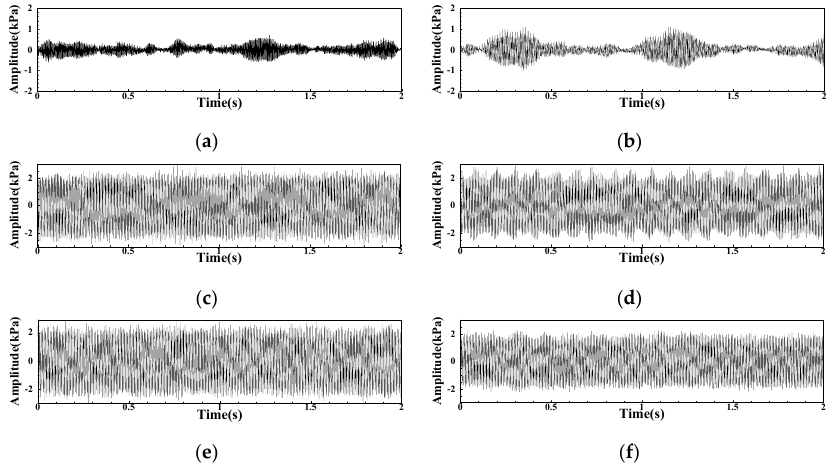
Taking the LA group as an example for the DP signal of the L combustor, Figure 13 shows the change result of the DP signal under the LA01-LA06 operating conditions. Under the operating conditions of LA01 and LA02, the fuel–air ratio is high, and the pressure pulsation waveform has obvious intermittence. Its waveform is the DP waveform signal under the classical FI state. When the fuel–air ratio is further reduced to the LA03 operating condition, the overall amplitude of the DP signal increases sharply and maintains in CI state. The signal changes of LB and LC groups are similar.